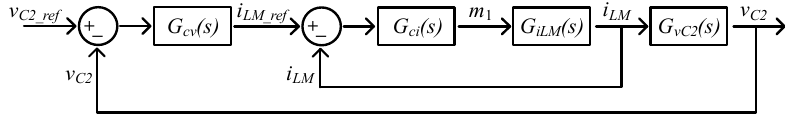
Figure 10. Block diagram of the cascaded control.